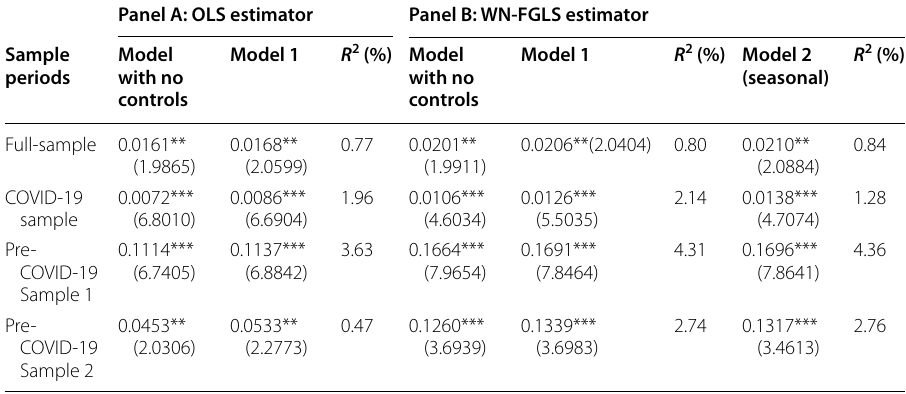
Table 2 The effect of oil prices on Japanese stock